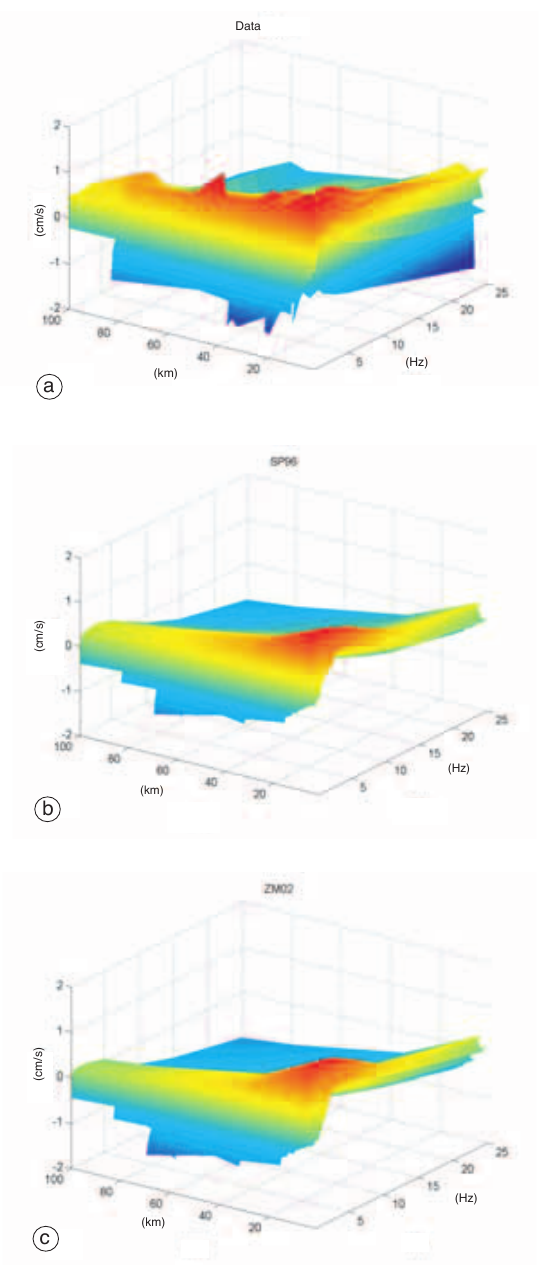
Fig. 3a-c. Comparison between PSV calculated from the data set (a) and two different attenuation functions: SP96 (b) and this study (ZM02